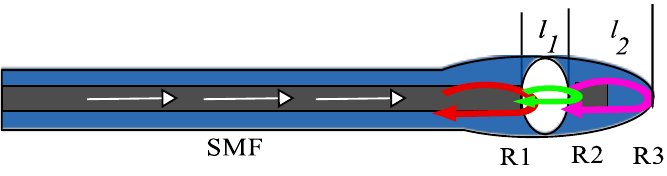
Figure 3. Schematic representation of the IFPI principle of operation.